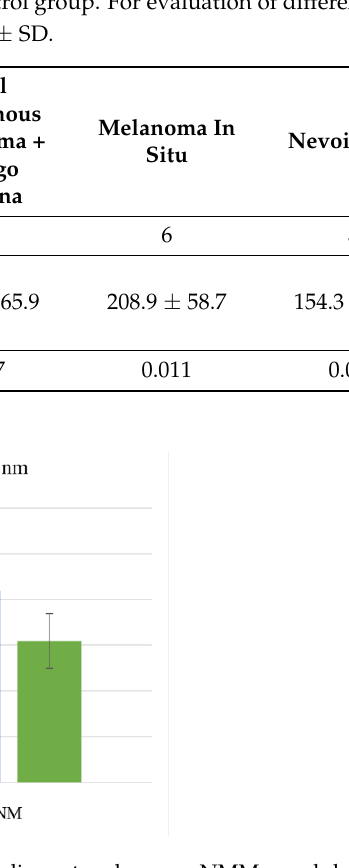
Figure 3. Fluorescence intensity in different types of malignant melanoma. NMM—nodular type malignant melanoma, SMM—superficial spreading-type melanoma, ALM—acral lentiginous malignant melanoma and lentigo maligna group, MIS—melanoma in situ, NM—nevoid melanoma. Statistically significant differences are related to the control group. Values are expressed as mean ± SD. * indicates p < 0.05 and *** indicates p < 0.001.